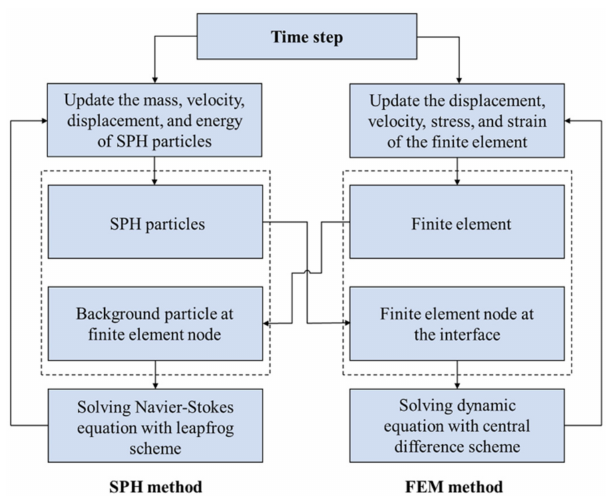
Figure 5. Solution process of SPH–FEM coupling